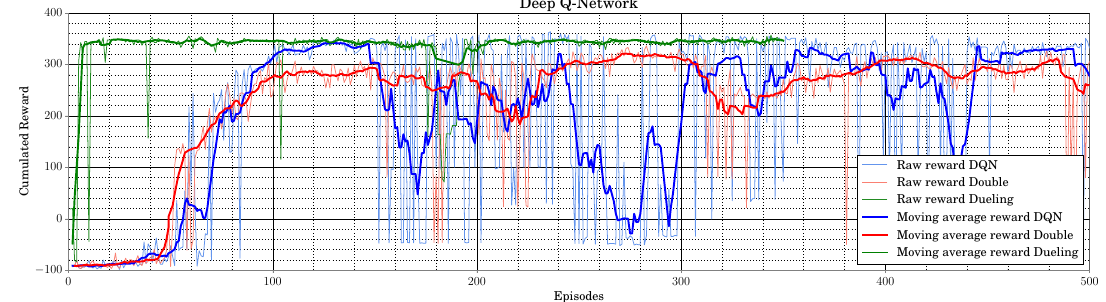
Figure 4. Cumulative reward during training in environment 1 for DQN (blue), DDQN (red) and D3QN (green) agents. Light-colored curves correspond to raw data while bold ones do to outlier-filtered moving